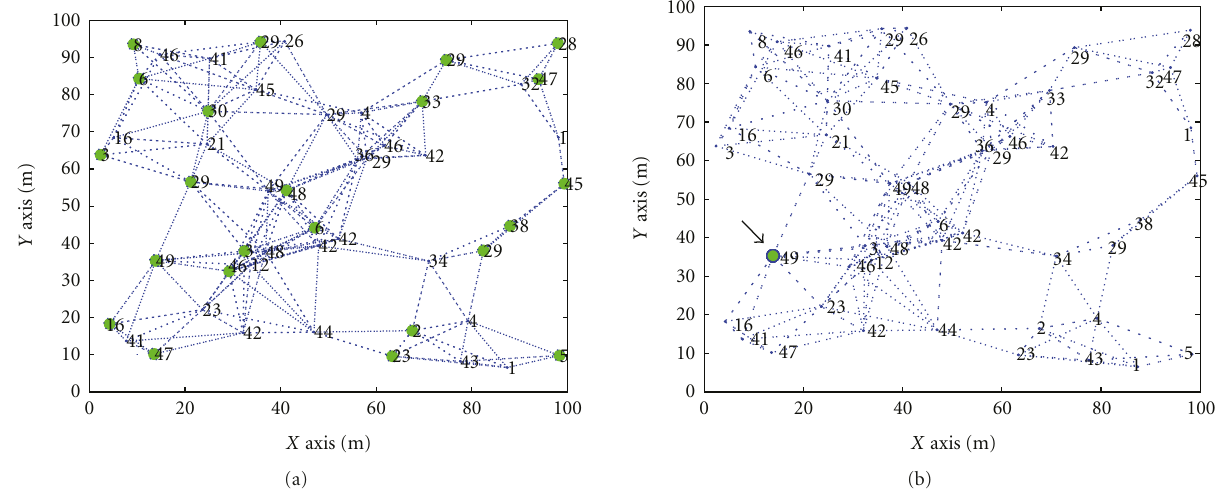
Figure 8: Snap shot of TPSO in ad hoc network with 50 nodes and 30 particles showing particles (a) before convergence, (b) after convergence.